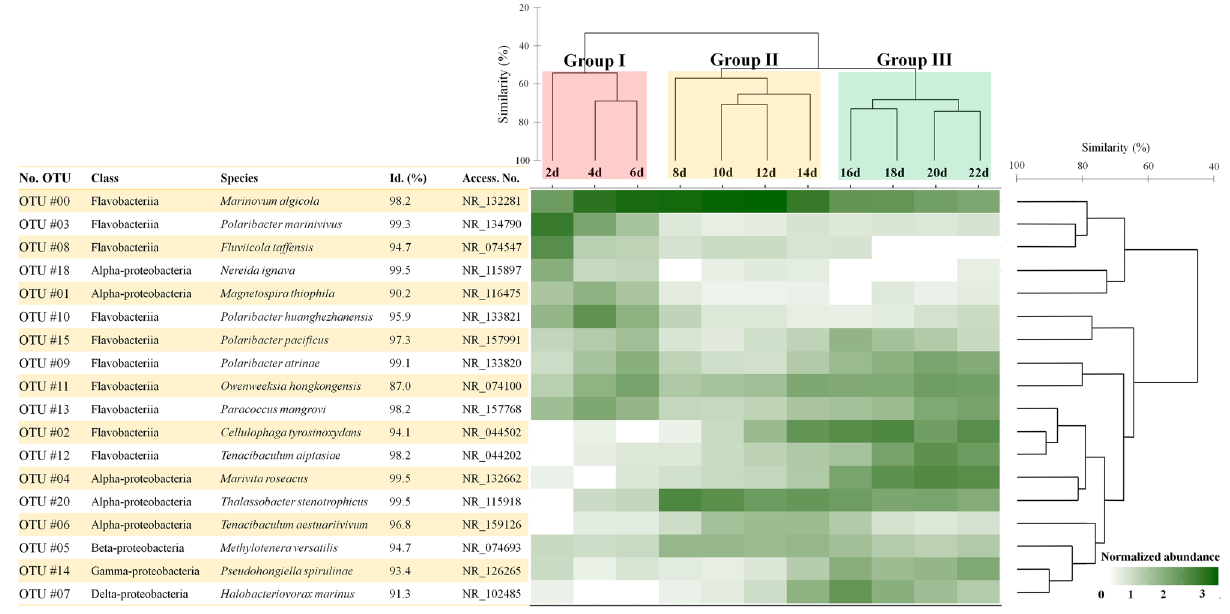
Figure 2. Heatmap showing the most abundant bacterial operational taxonomic units (OTUs). Each OTU displayed a relative abundance of > 1% in at least one sample. The heatmap displayed the fourth root-normalized data at the range of 0.0 to 3.0. Hierarchical agglomerative clustering using the group average of the most abundant bacterial OTUs using the Bray–Curtis similarity method. This figure was generated with RStudio v.1.2.5042 (https:// rstud io.